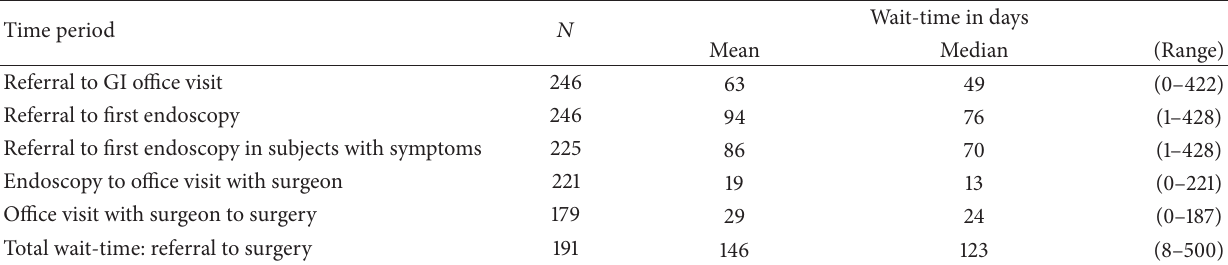
Table 2: Calculated wait-times (mean, median, and range) for office visits and procedures for included subjects for several time periods from initial referral to the PGA office through to surgery by a colorectal surgeon. Subjects were excluded from the calculations if they were not referred to a surgeon or if they declined surgery. Subjects were also excluded from the time to surgery calculations if they had preoperative